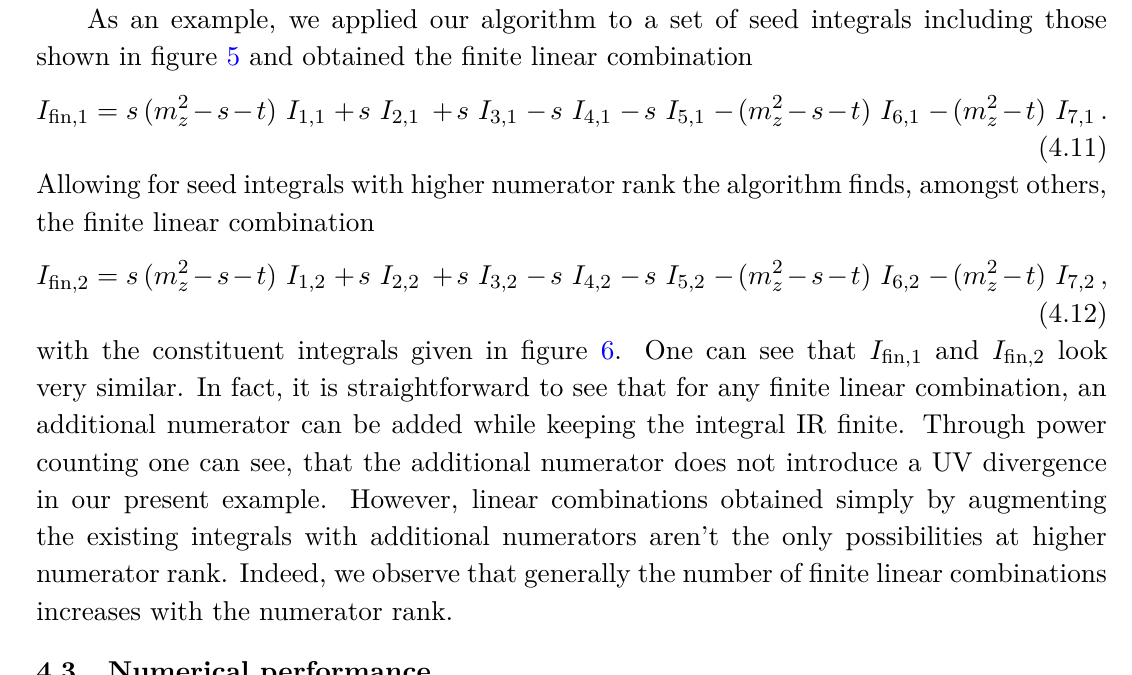
Figure 5. Integrals appearing in (4.11). I 1 , 1 is the corner integral of the topology under con- sideration. I is a second integral in the topology, but with a numerator ( k 2 − m 2 2 , 1 equal to the difference of the momenta of the edges marked by the thin dashed lines. Integrals I 3 , 1 , I 4 , 1 , I 5 , 1 , I 6 , 1 , I 7 , 1 belong to subtopologies. All integrals are defined in d = 4 − 2 (cid:15)